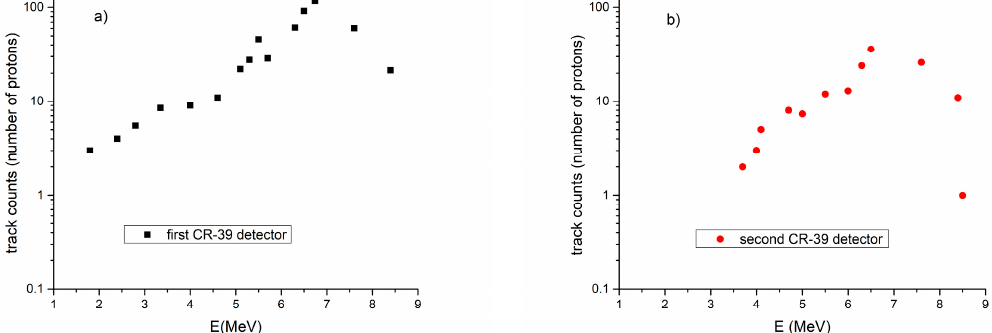
Figure 10. Dependence of number of proton tracks on the proton energy obtained for ( a ) first and ( b ) second CR-39 detector in the case of the interaction of the high-power laser pulse with the Al target of 5 μ m thickness.